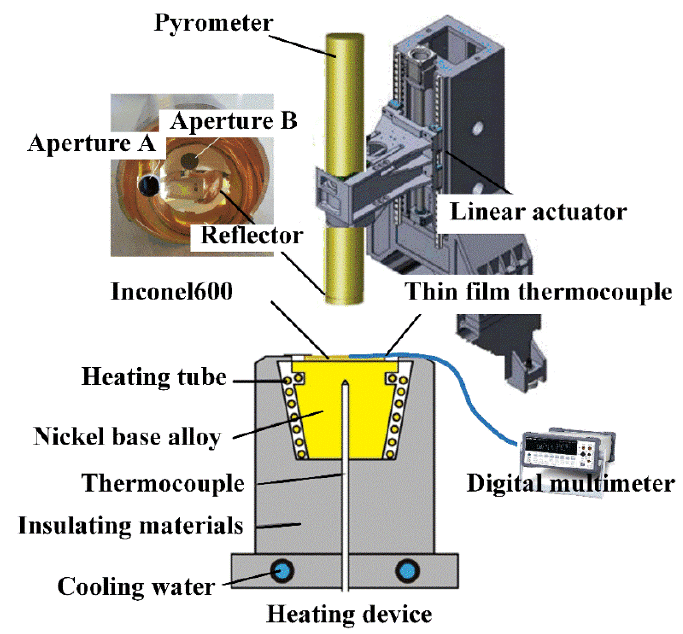
Figure 4. Schematic diagram of the structure of experimental device.